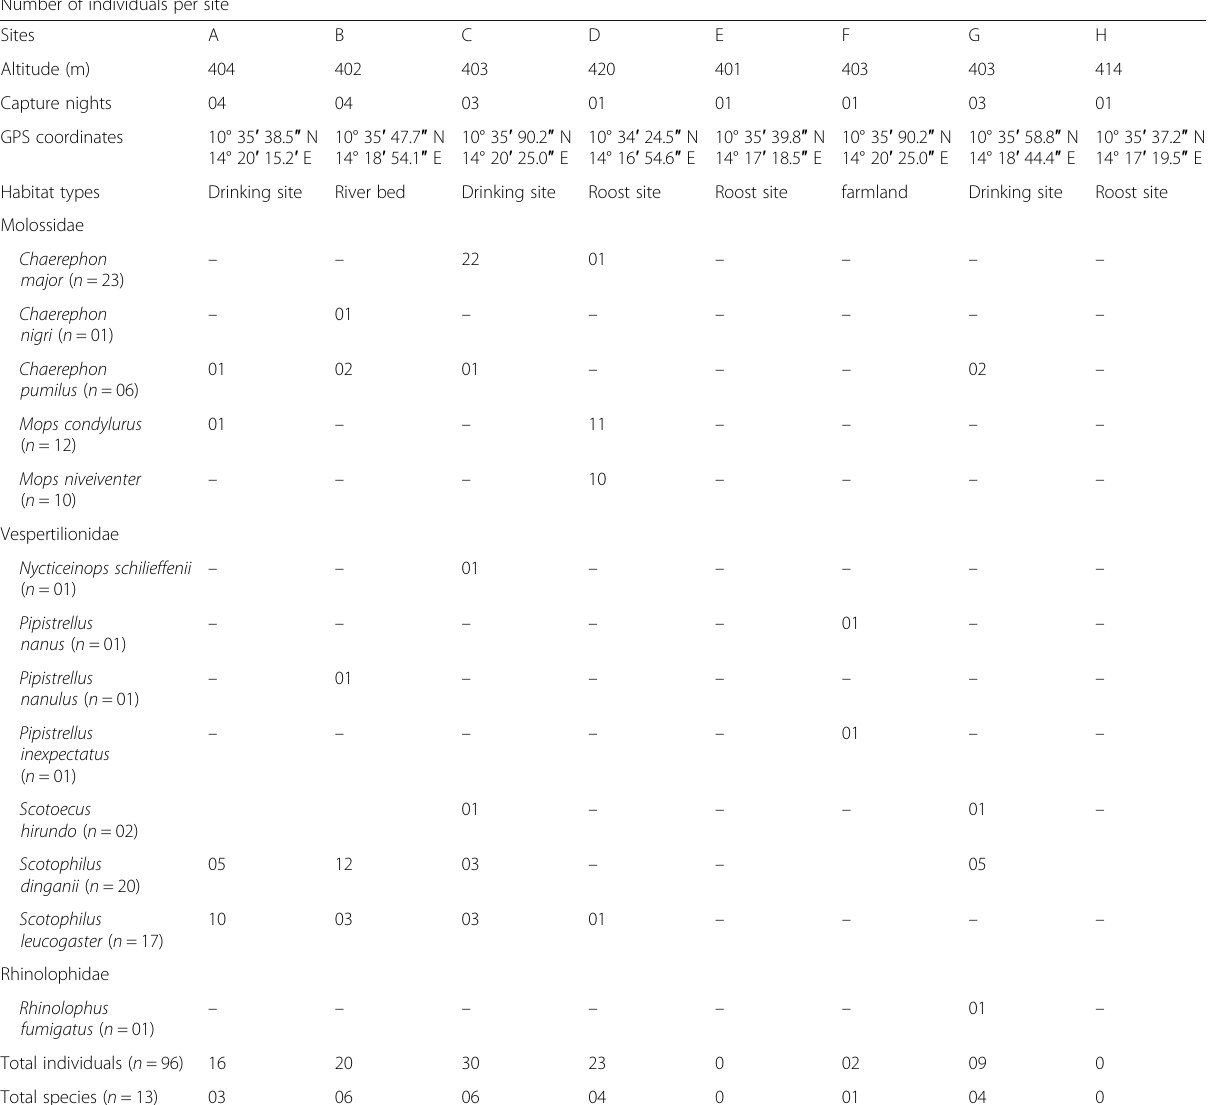
Table 1 Bat species recorded in eight survey areas in Maroua, Cameroon (numbers in parentheses refer to captured individuals) Number of individuals per